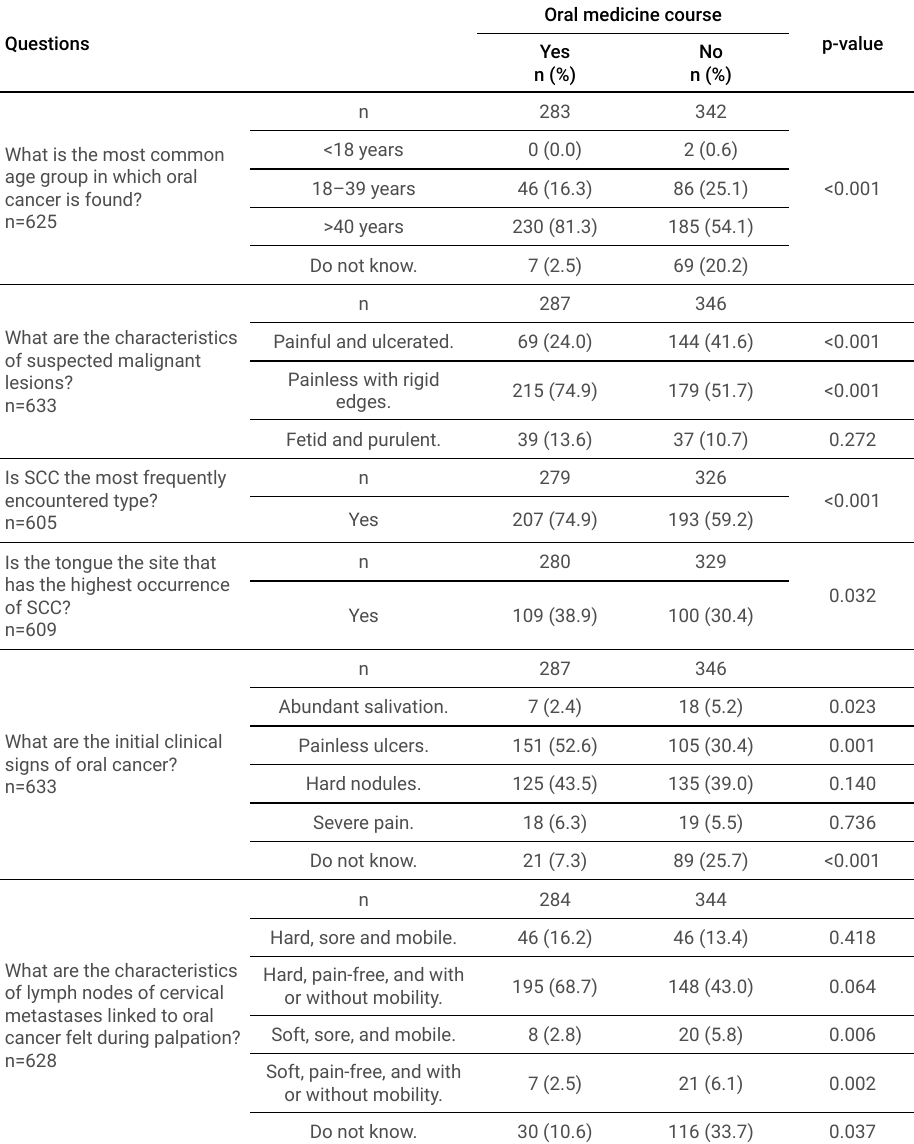
Table 3. Undergraduate Dental students’ knowledge regarding oral cancer (N= 646; Paraná,